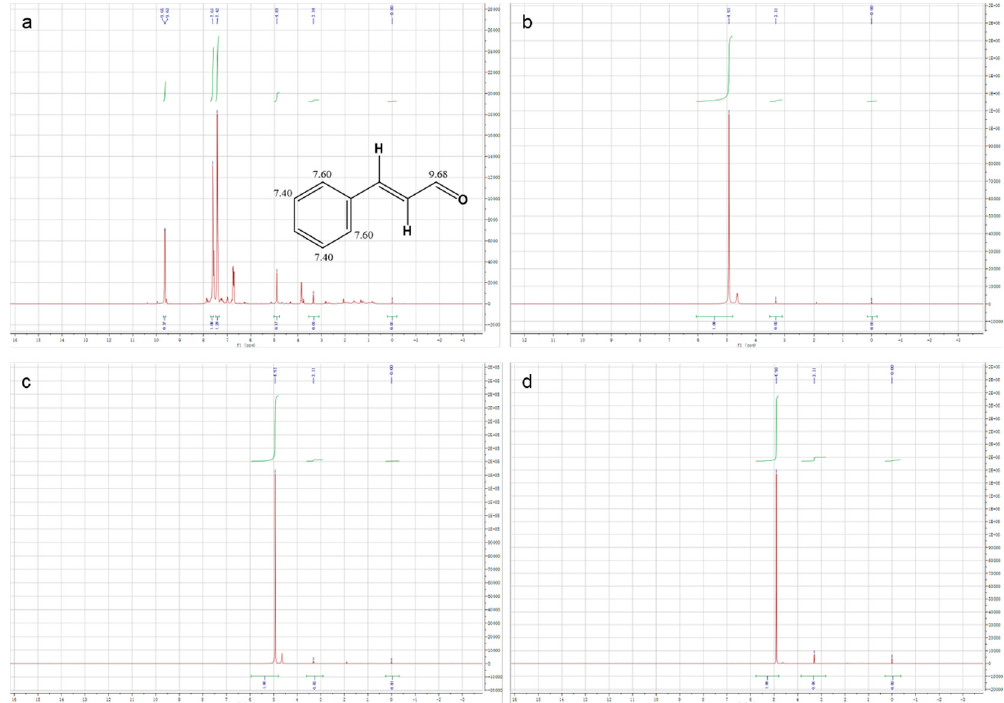
Figure 8. 1 H NMR spectra of ( a ) CEO, ( b ) CEO-SWSM, ( c ) CEO-PM, and ( d ) CEO-UM microcapsules.